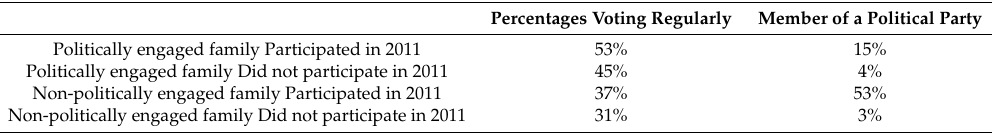
Table 2. Family political engagement, and young people’s political activity in 2010–2011 and